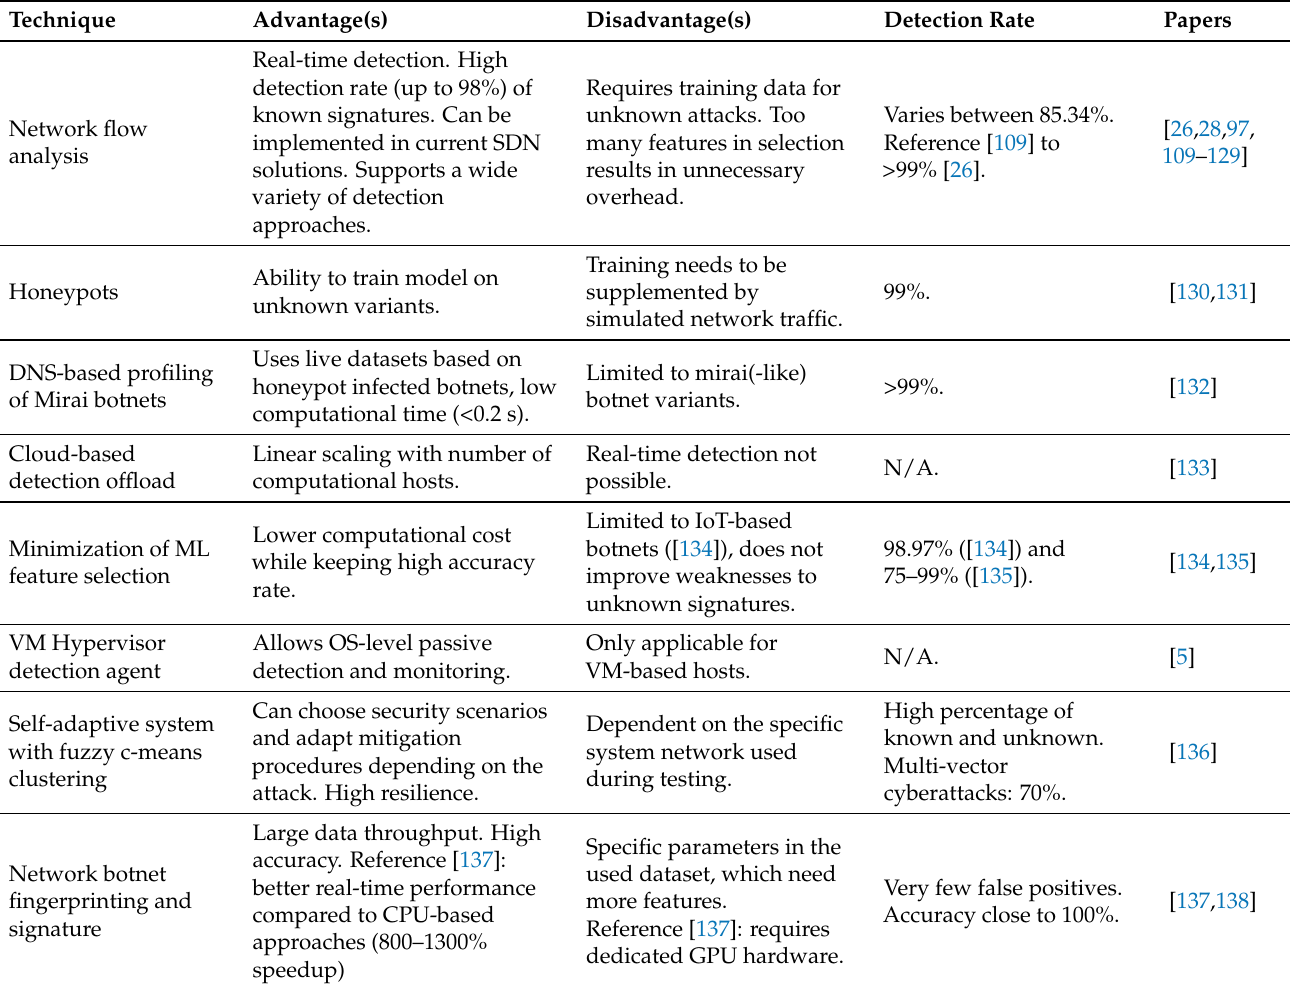
Table 5. Papers describing detection of botnets using machine learning based techniques. Each column describes the overall technique, known advantages, disadvantages, detection rate and related papers respectively. Technique Detection Rate